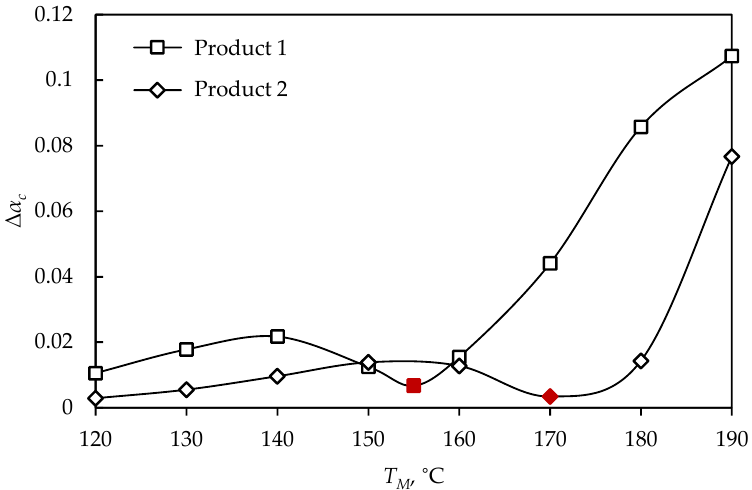
Figure 11. The differences between the maximal and minimal vulcanization degrees of rubber wheels at different mold temperatures.